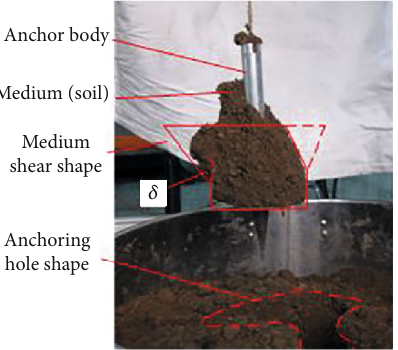
Figure 6: Anchoring model of the anchoring system after barbs